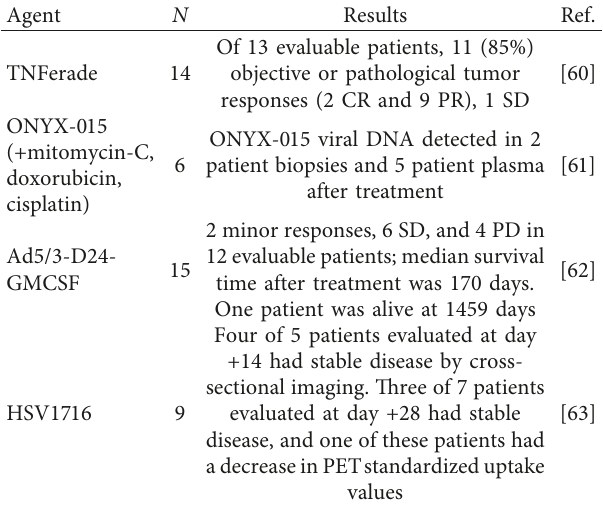
Table 1: Clinical trials of intratumoral viral vector therapy in soft tissue